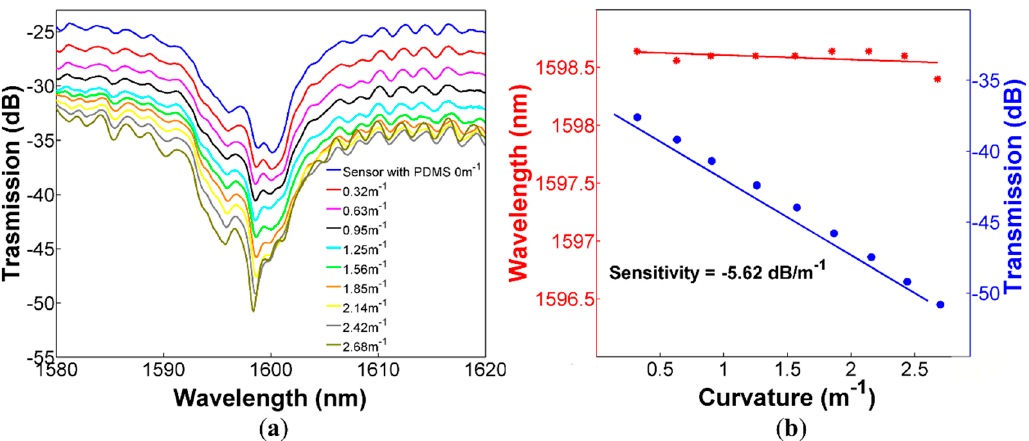
Figure 5. ARROW sensor covered with PDMS ( a ) Spectral response of the sensor for curvatures from 0 to 2.68 m − 1 ; ( b ) Dip wavelength shift and transmitted intensity changes as a function of the applied curvature.